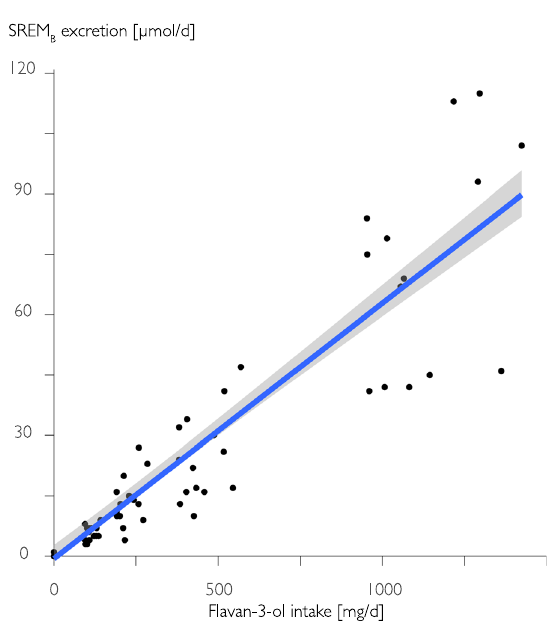
Figure 3. Association between flavan-3-ol intake and biomarker (SREM B ) excretion in male adults (n = 14). The data show a strong correlation between intake and biomarker (R 2 : 0.86 (95% CI 0.8l;